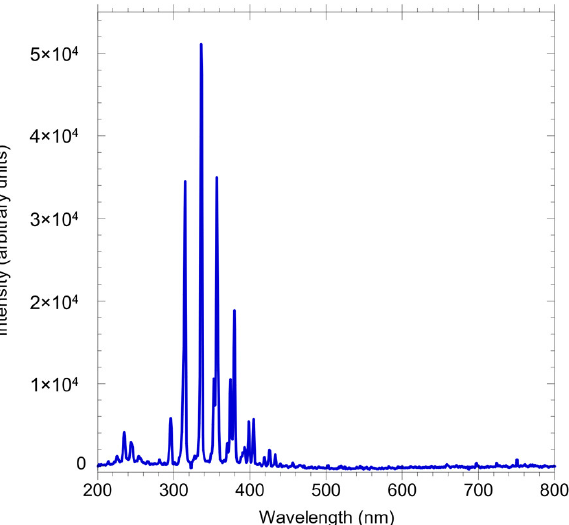
Figure 3. A typical emission spectrum of air plasma as a function of the wavelength from 200 to 800 nm.